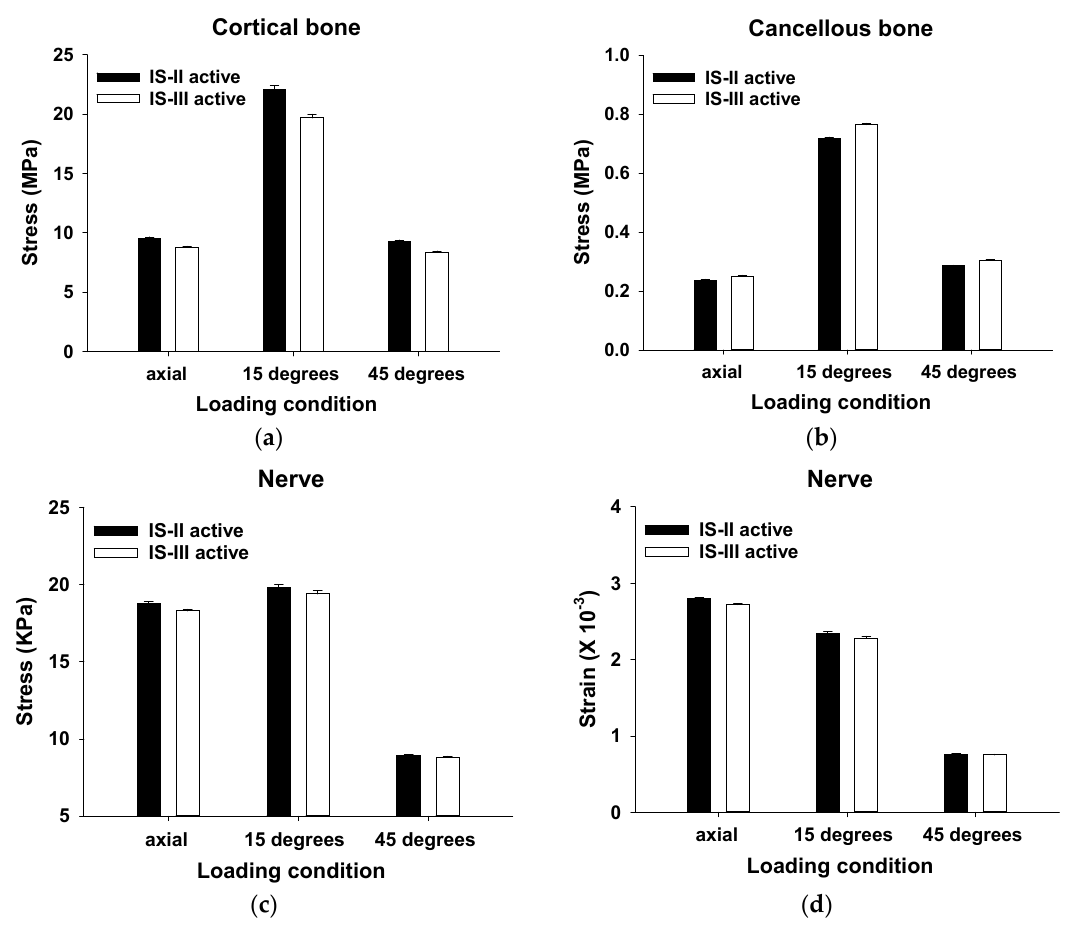
Figure 6. The Max EQS values in ( a ) cortical bone, ( b ) cancellous bone, ( c ) and the nerve and ( d ) the minimum principal strain of the nerve under loading of 100 N (axial), 100 N (15°), and 30 N (45°).